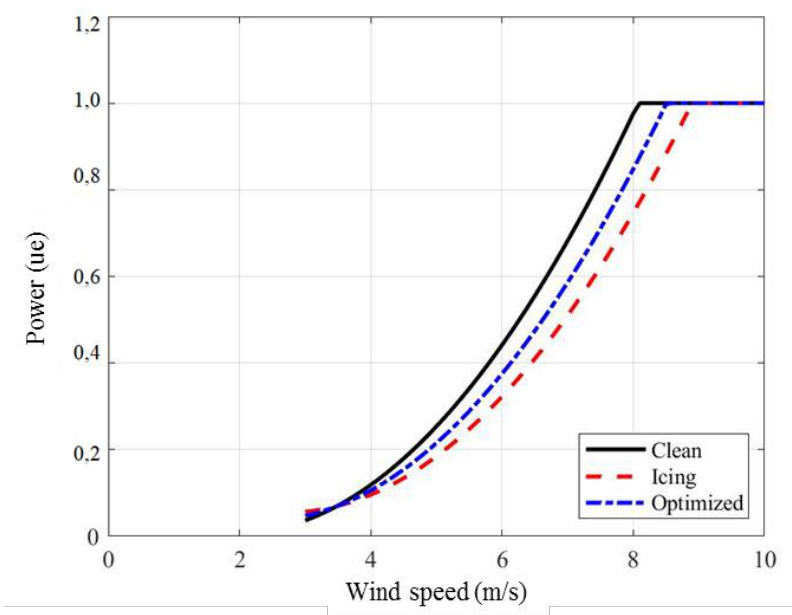
Table 4. Icing model comparison between the developed model and the Finnish Icing Atlas. Location